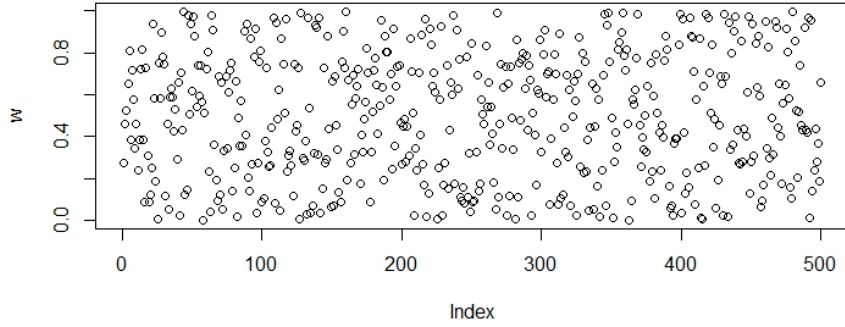
Figure 4. Population initialization using WELL distribution.